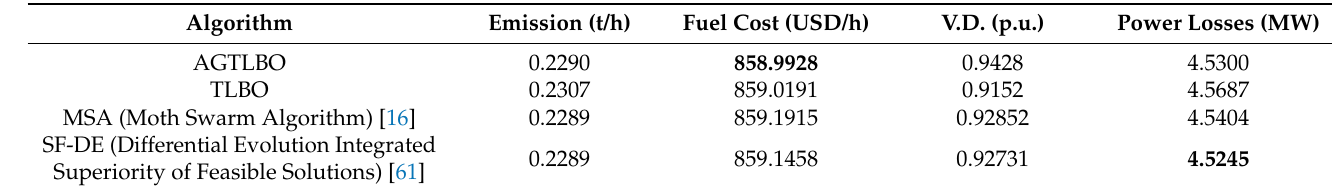
Table 7. Optimal results by different algorithms for Case